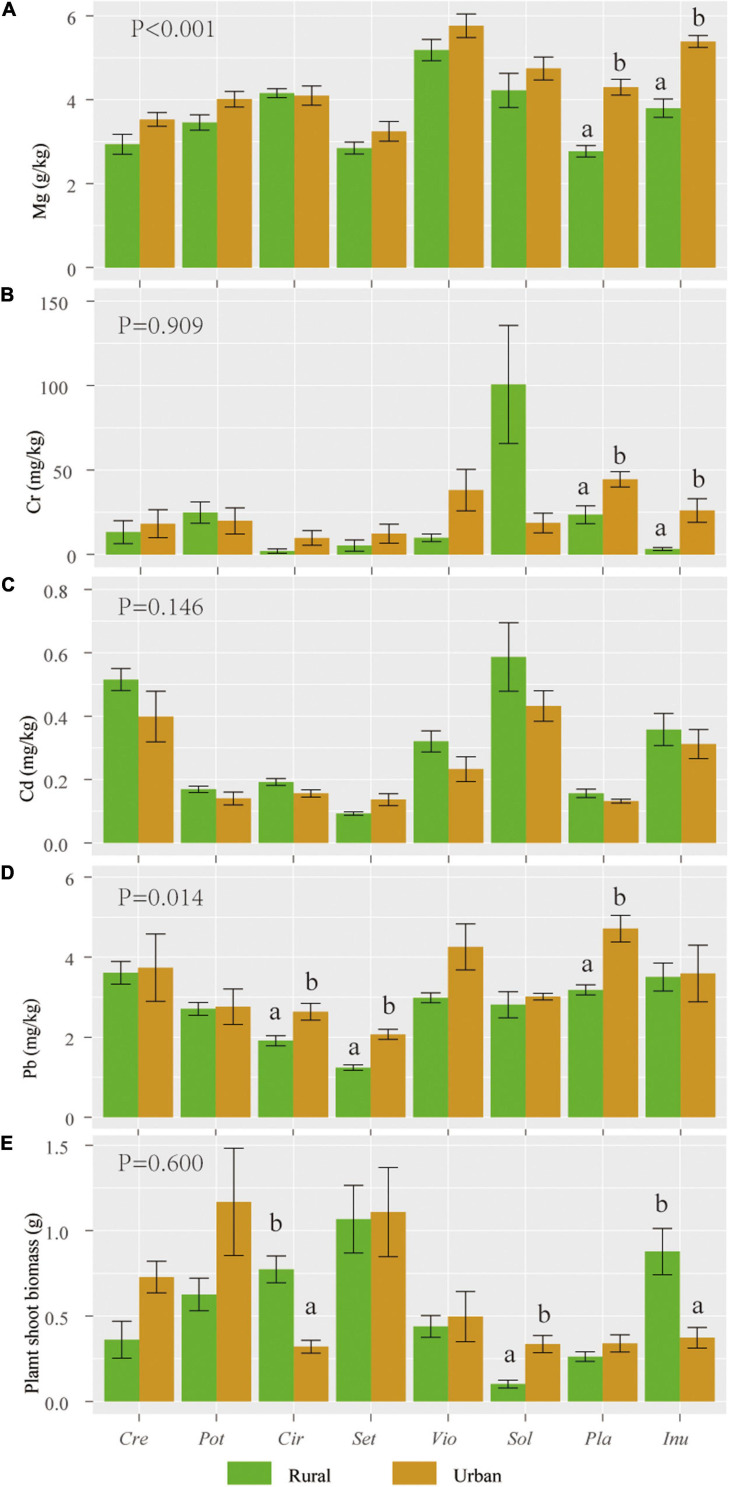
Mean (standard error, SE) values of Mg (A), Cr (B), Cd (C), and Pb (D) contents and individual biomass (E) of 8 host species in rural and urban areas (n = 5). Abbreviations in the X axis: Sol, Solanum nigrum; Pot, Potentilla supina; Cir, Cirsium setosum; Inu, Inula japonica; Pla, Plantago depressa; Cre, Crepidiastrum sonchifolium; Set, Setatia viridis; Vio, Viola philippica. Different letters indicate 0.05 LSD significant differences. P values indicate LSD differences in heavy metal content and biomass of plant species in urban or rural areas (n = 8).